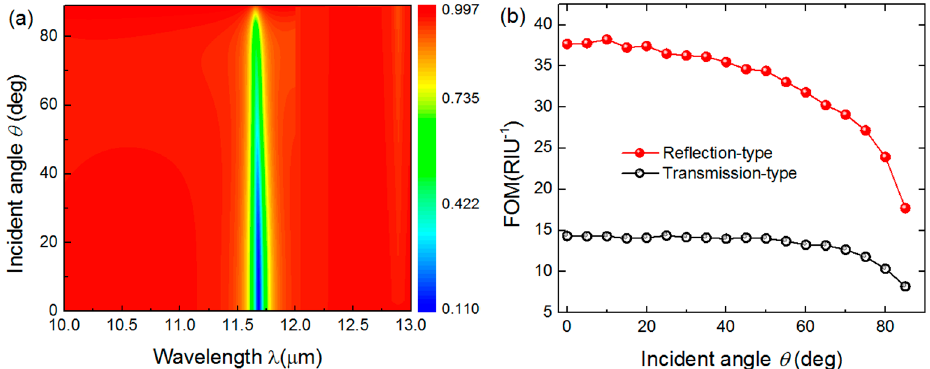
Figure 6. ( a ) Reflectance of reflection-type sensor mapping with varying incident angles and wavelength when Λ = 400 nm, H = 100 nm, W = 40 nm, and E f = 0.3 eV; ( b ) The calculated FOM of the transmission-type (black hollow sphere) and reflection-type (red solid sphere) sensors as a function of θ .